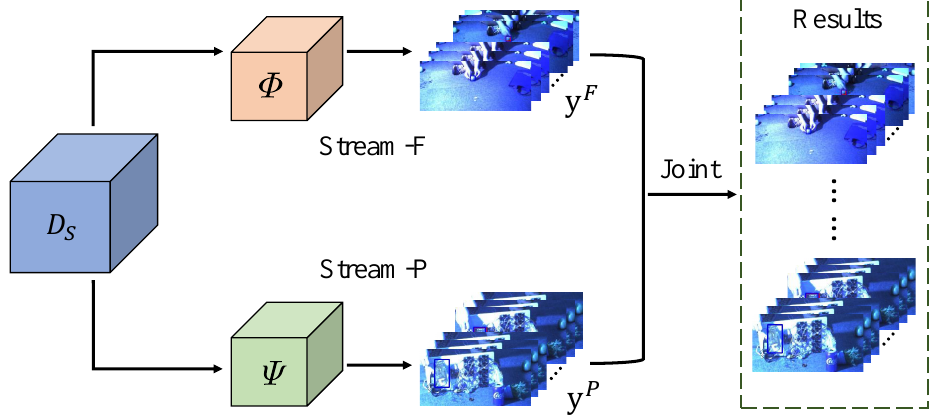
Figure 1. Our proposed dual-transfer module. D S represents the source domain of transfer learning. In stream-F, we utilize the feature-based transfer learning method. In stream-P, we utilize the parameter-based transfer learning method.